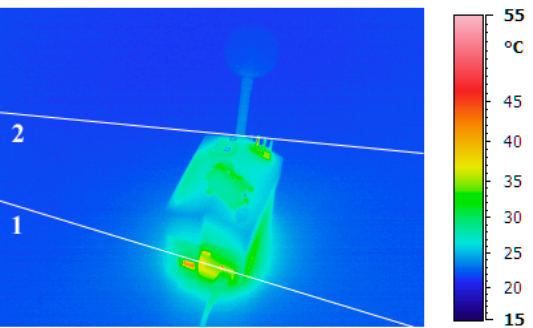
Figure 3. First case, thermal imaging after 24 h.